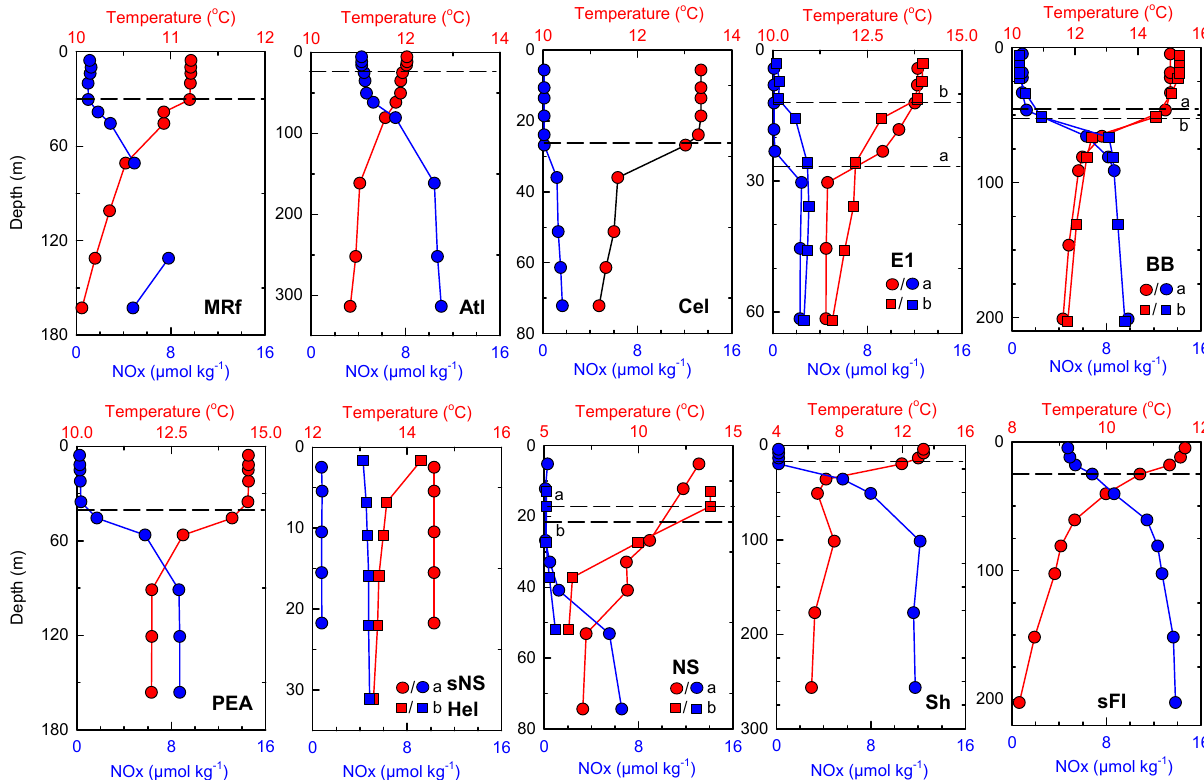
Figure 2. Vertical profiles of temperature ( ◦ C) and nitrate + nitrite (NO x , µmolNkg − 1 ) over the upper water column. Dashed lines indicate mixed layer depths. Several sites were sampled twice during the cruise and these are denoted with a and b (e.g. BBa,